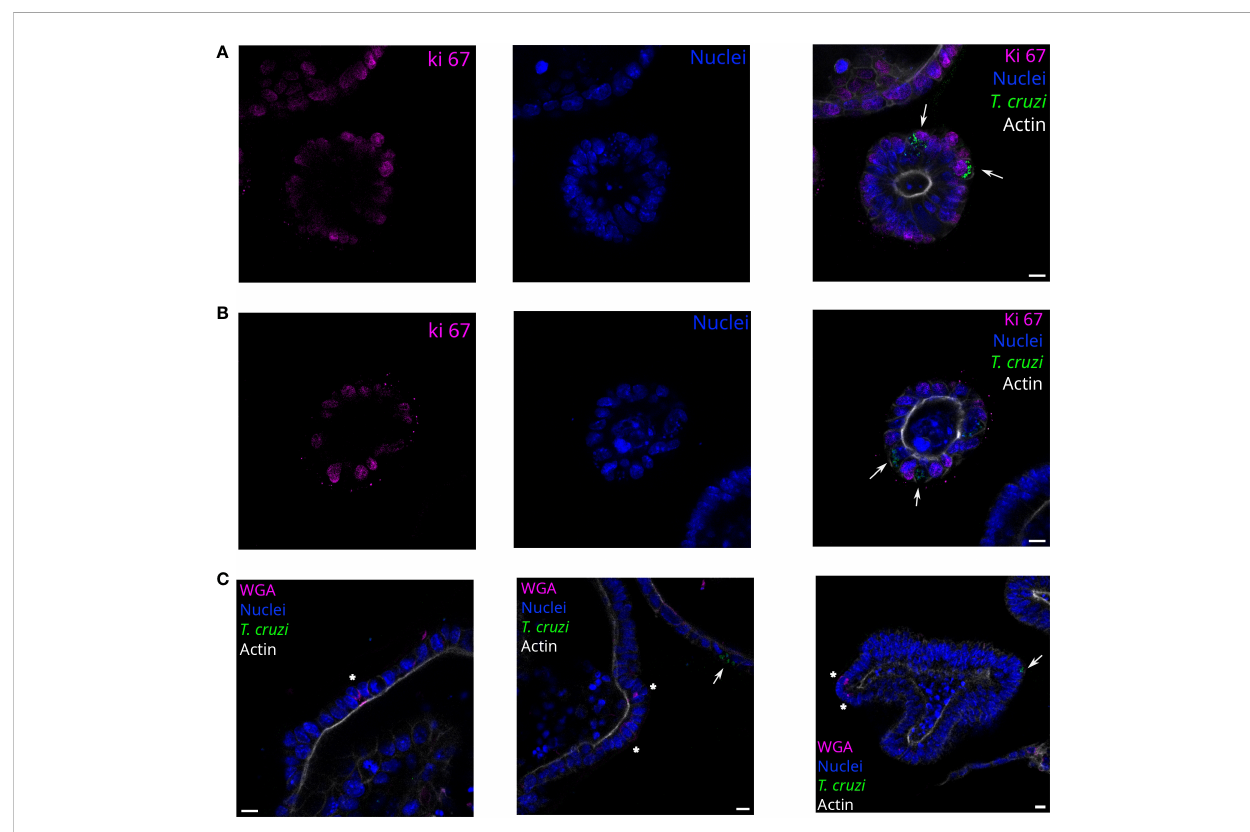
FIGURE 4 T. cruzi infects proliferating or non-proliferating cells but not goblet cells. Representative images of organoids infected with parasites (MOI 1:15) and incubated for 72 h. Arrows indicate infected cells. Parasites are able to infect Ki67 positive (A) and negative (B) cells. Nuclei (blue): Hoechst 33342 staining, T. cruzi (green): anti-mitochondrial peroxiredoxin immune-staining, and Actin (white): phalloidin Texas Red staining. (C) Labeled goblet cells (indicated with *) were uninfected, while some infected cells were detected in the same fi eld. Nuclei (blue): Hoechst 33342 staining, T. cruzi (green): anti-mitochondrial peroxiredoxin immune-staining, Actin (magenta): phalloidin-Alexa Fluor 647 staining, and goblet cells (white): WGA-Alexa Fluor 555 staining. Scale bar: 10 m